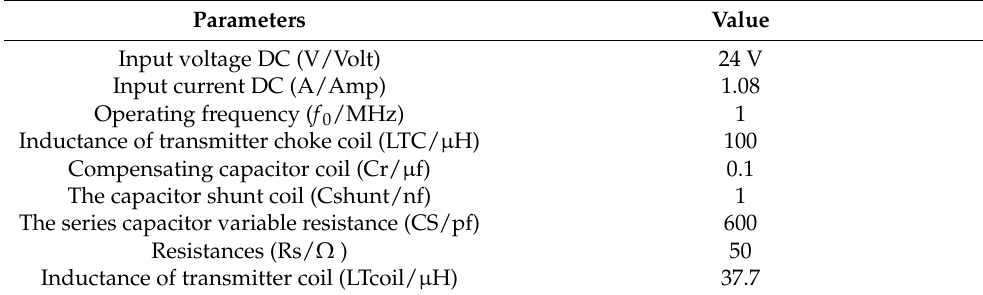
Table 1. Parameters of Class E PA MTSCC